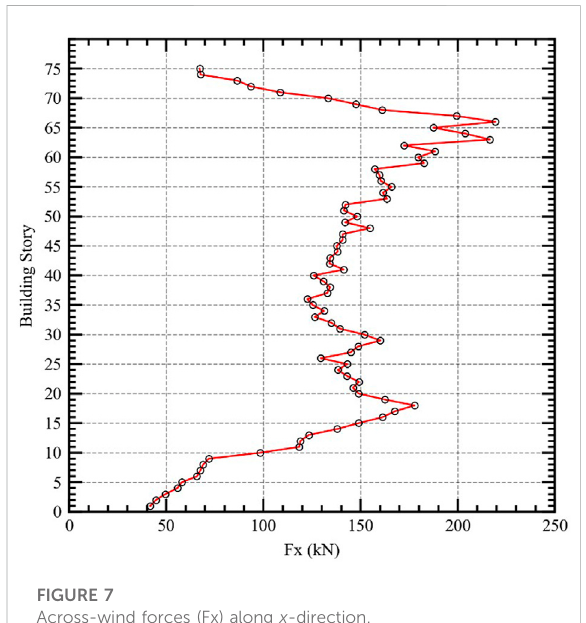
FIGURE 7 Across-wind forces (Fx) along x -direction.